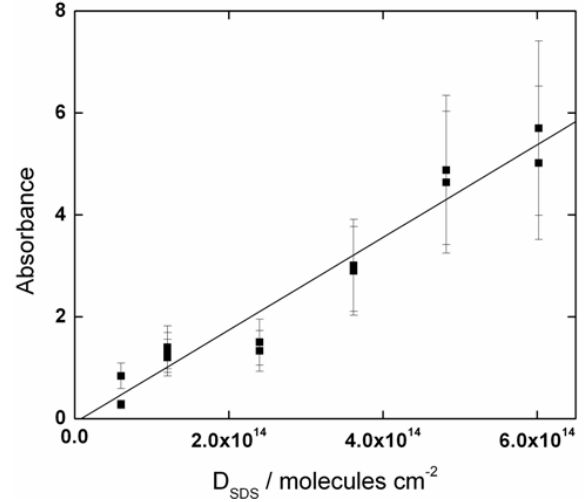
Figure 1. The infrared absorbance of the CH dodecyl sulfate (SDS) molecules on Ge substrate. The density of SDS molecules (D was estimated using the casting technique assuming complete substrate coverage.